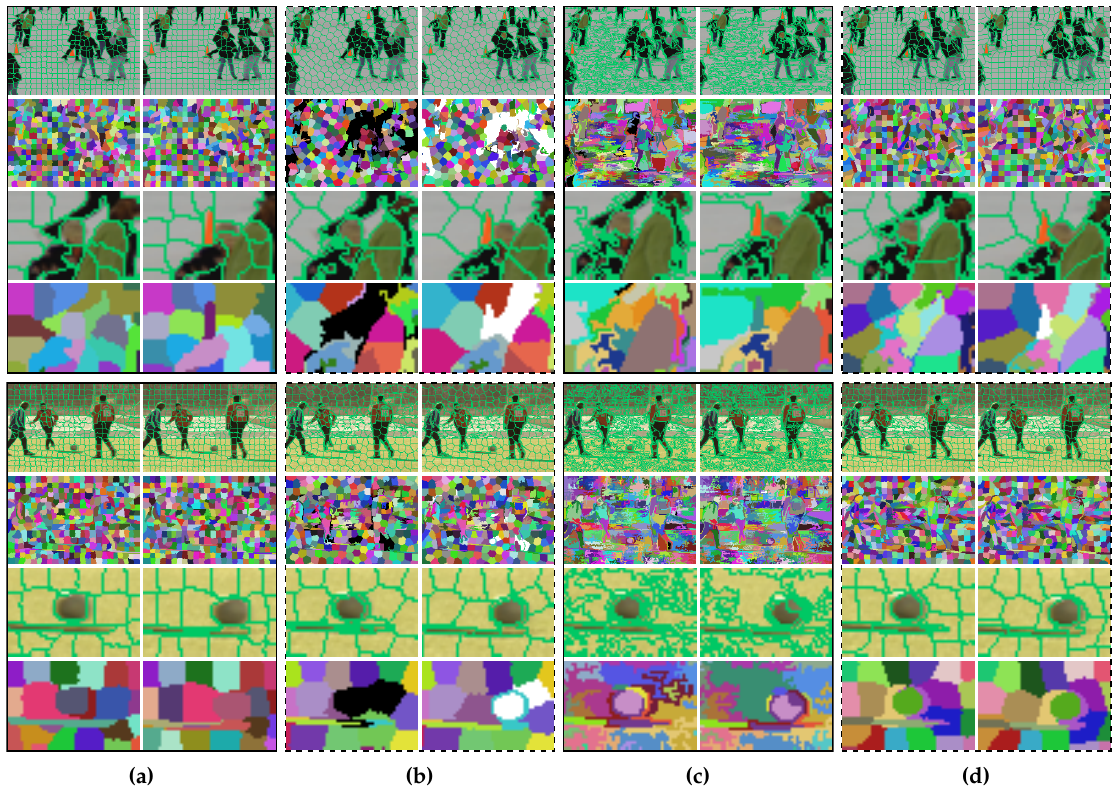
Figure 8. Examples of supervoxel segmentation. ( a ) PARW [17]; ( b ) TSP [20]; ( c ) vSEEDS [19]; ( d ) ours. The algorithms extract approximately the same number of supervoxels. Superpixel boundaries are plotted in the first, third, fifth, and seventh rows. In the remaining rows, we paint voxels of the same supervoxel using the same color. Disappearing and appearing superpixels are painted using black in the first frames and white in the second frames, respectively. The third, fourth, seventh, and eighth rows zoom in on regions of the first, second, fifth, and sixth rows, respectively.